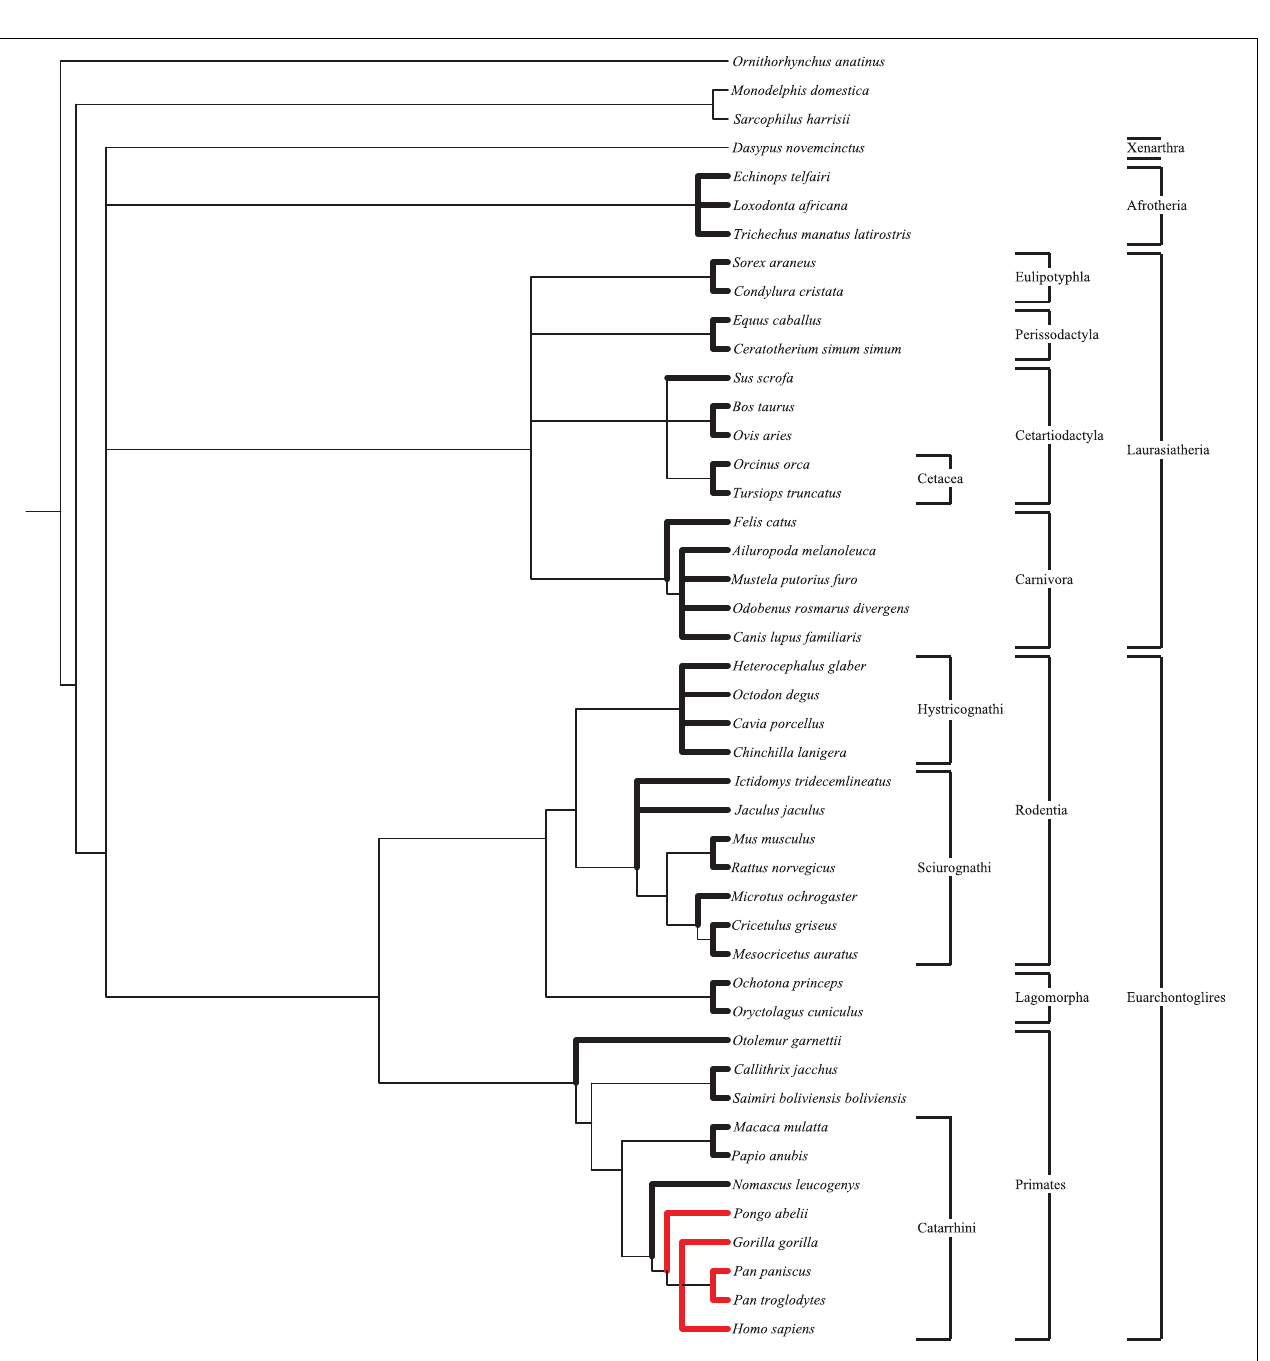
FIGURE 1 | Species tree. Species tree, generated by NCBI Taxonomy Browser, used as a guide in PAML for the calculation of d N and d S values under the free ratio model. Lineages presented in this study are bolded. Great ape species are shown in red for ease of comparison. Notable clades discussed herein are shown.